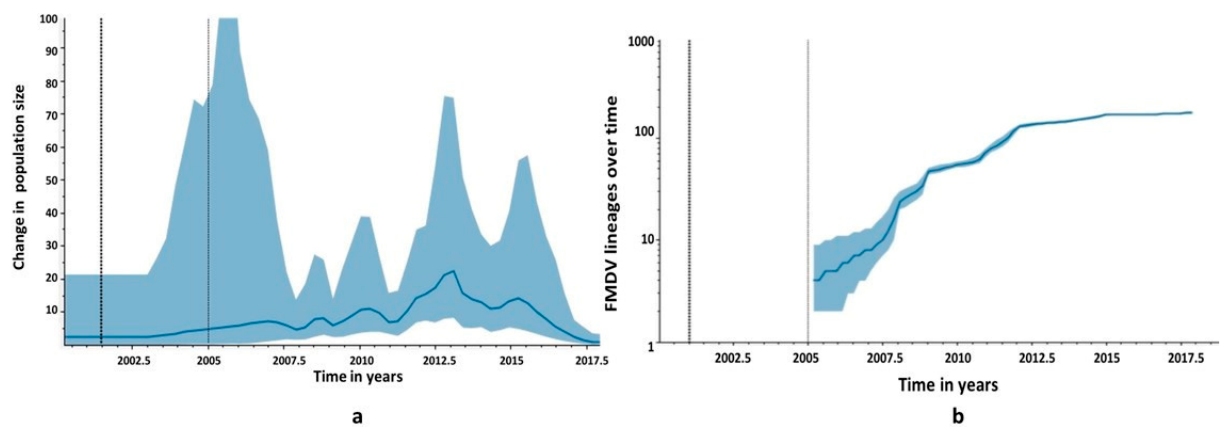
Figure 5. Reconstruction of the demographic history of FMDV serotype A in Pakistan. ( a ) Sky Grid Plot. The y-axis represents the change in effective population size (Ne) and the x-axis represents time in years. The peaks in population size are visible. The solid interval represents the 95% HPD support. ( b ) Lineages Through Time plot. The y-axis depicts the logarithmic increase in the number of FMDV lineages over time in years along the x-axis. The dark dotted line represents the mean tMRCA and the light dotted line represents 95% BCI.